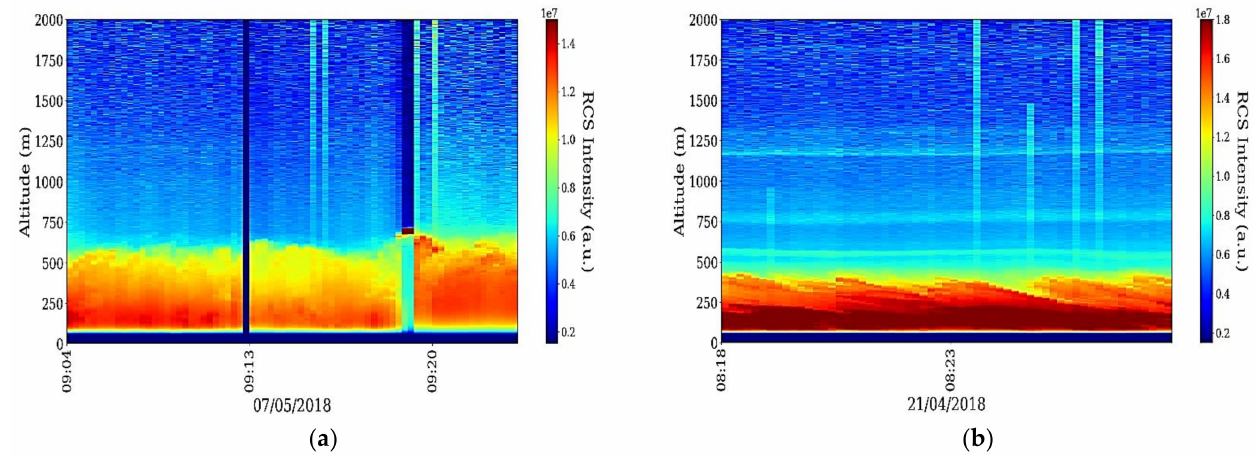
Figure 8. RCS timeseries: ( a ) 07 May 2018, 15 s temporal resolution; ( b ) 21 April 2018, 10 s temporal resolution.